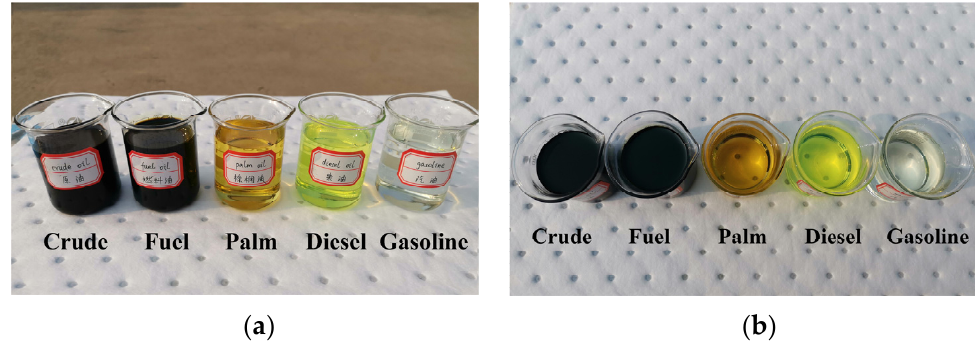
Figure 5. ( a ) Front view of the experimental oils and ( b ) top view of the experimental